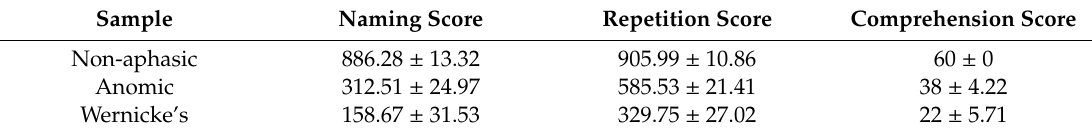
Table 6. Average scores obtained for each assessment